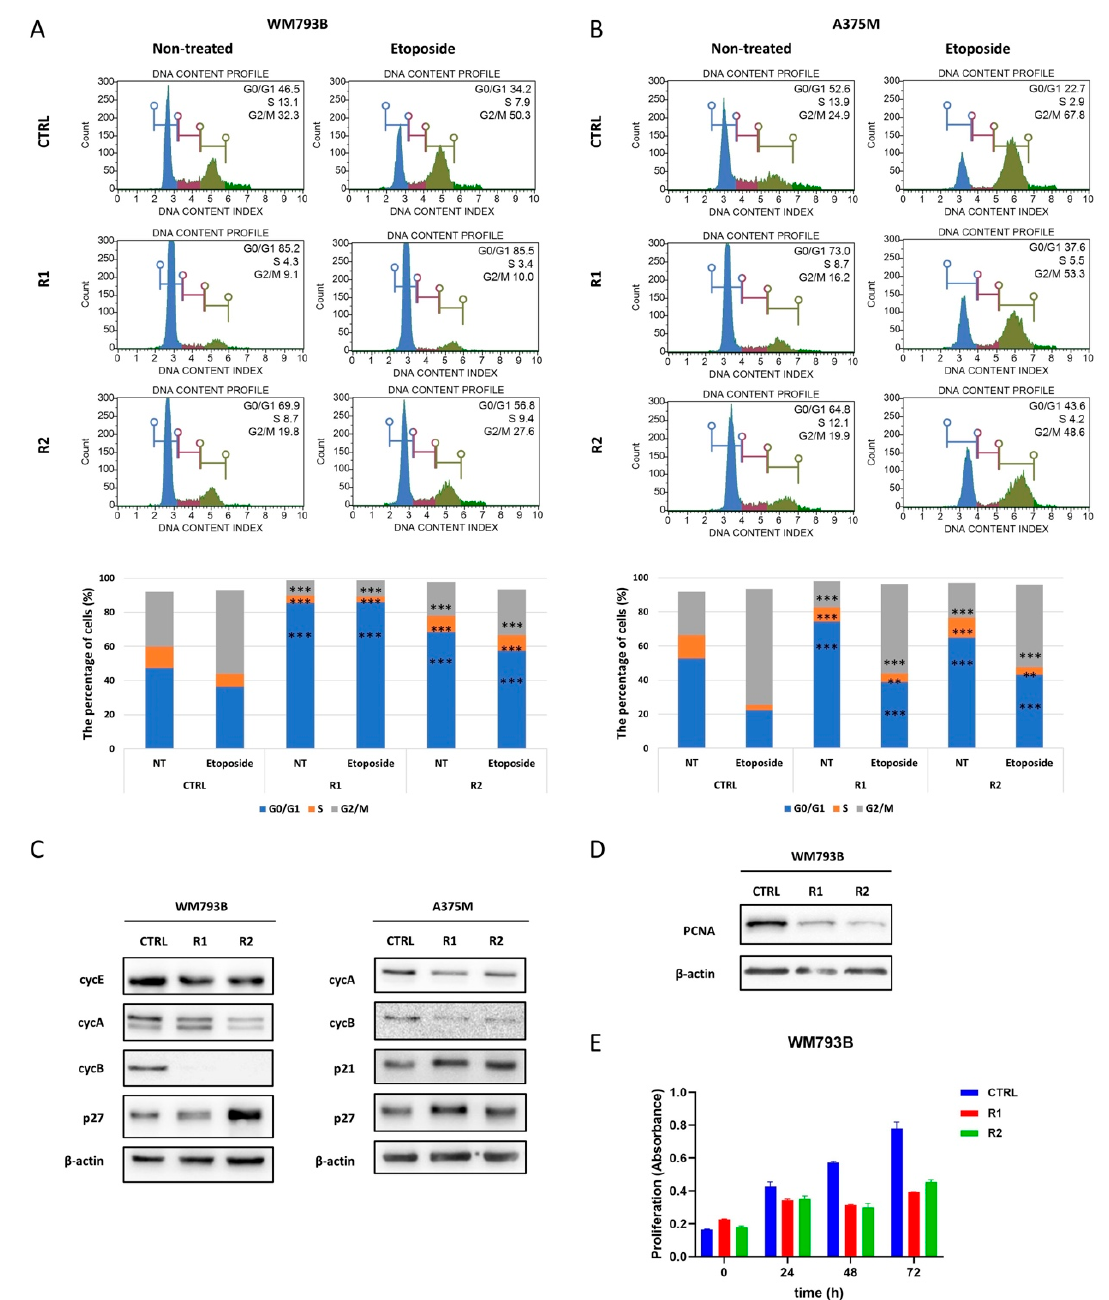
Figure 7. The cell-cycle analysis in the vemurafenib-resistant cell lines WM793B and A375M. The cell cycle phase distribution of parental (CTRL) and corresponding vemurafenib-resistant cells (R1 and R2) was analyzed by flow cytometry ( A , B ). The experiment was performed with untreated cells (NT) and after treatment with etoposide for 24 h. Statistical analysis was performed using MedCalc (v. 18.11.3). The normal distribution of continuous variables was confirmed using the D’Agostino–Pearson test, and the parametric statistical test one-way ANOVA with the Tukey–Kramer post hoc method was used. Asterisks indicate the statistical significance of each cell cycle phase in the resistant cell lines compared to the parental line. A p -value less than 0.01 is flagged with two stars (**), and a p -value less than 0.001 is flagged with three stars (***). Protein expression of cell cycle regulators ( C ) and PCNA proliferation marker ( D ) in parental (CTRL) and resistant (R1 and R2) cells. β -actin was used as a loading control. The proliferation rate of parental (CTRL) and resistant (R1 and R2) WM793B cells ( E ). The mean values of three biological replicates with standard deviations are shown.